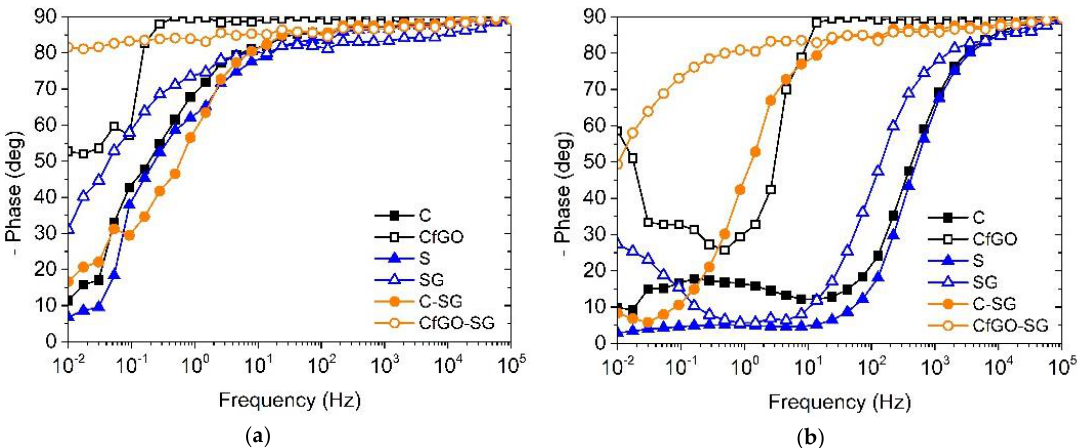
Figure 11. Bode phase diagrams of the samples ( a ) at the beginning and ( b ) after 24 h of immersion in test solution.